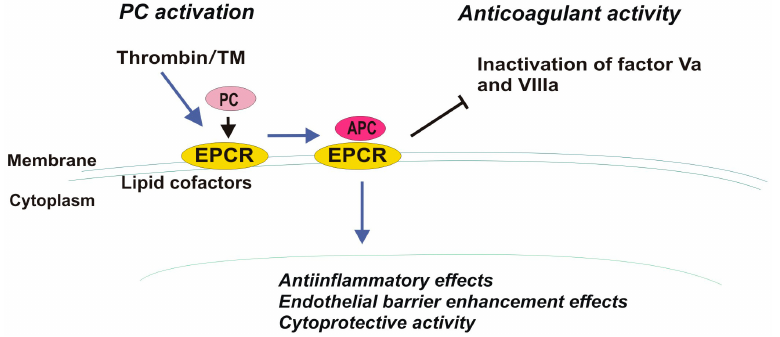
Figure 1. Protein C (PC) activation mediated by thrombin, thrombomodulin (TM) and EPCR (endothelial protein C receptor) and its diverse biological functions (anticoagulant and cellular effects).